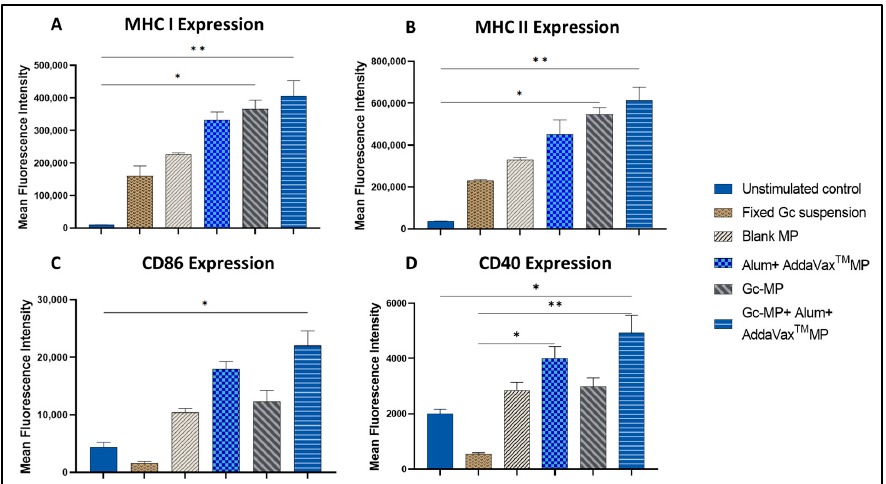
Figure 5. Expression of MHCI, MHCII, and co-stimulatory molecules CD40, CD86 on the surface of the dendritic cells induced with adjuvanted gonococci vaccine microparticles. DC 2.4 cells (5 × 10 4